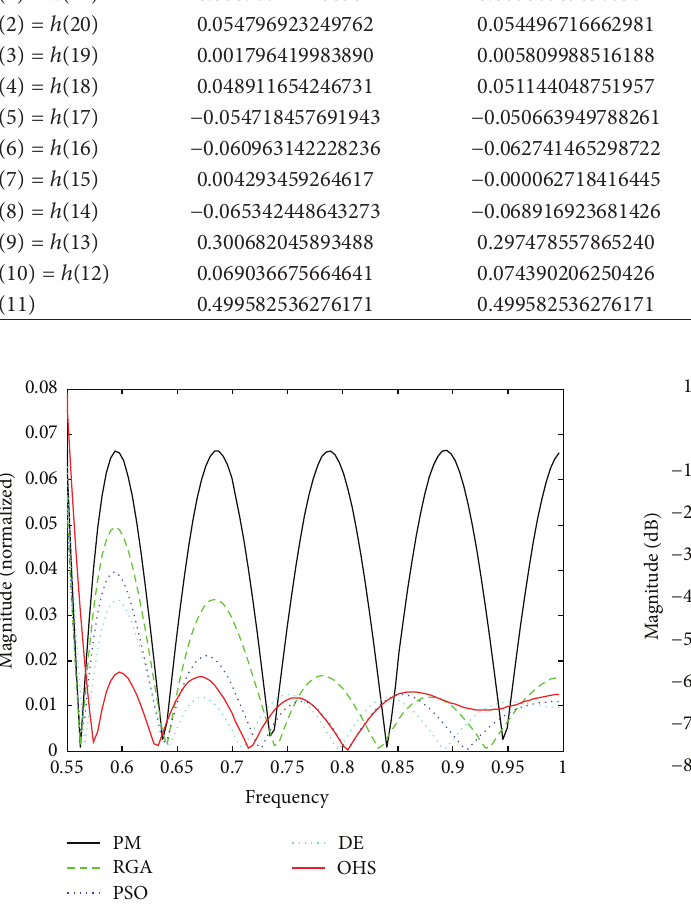
Figure 4: Normalized stop band ripple plots for the FIR LP filter of order 20.